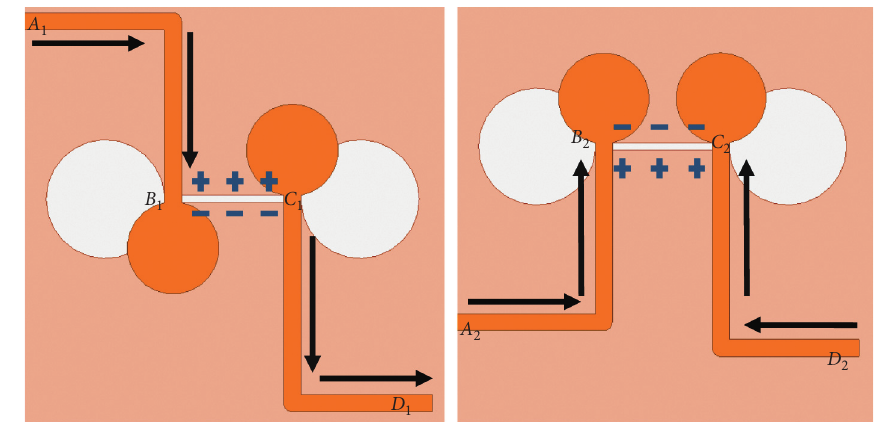
Figure 11: Distribution of current and electric field of the feeding network.